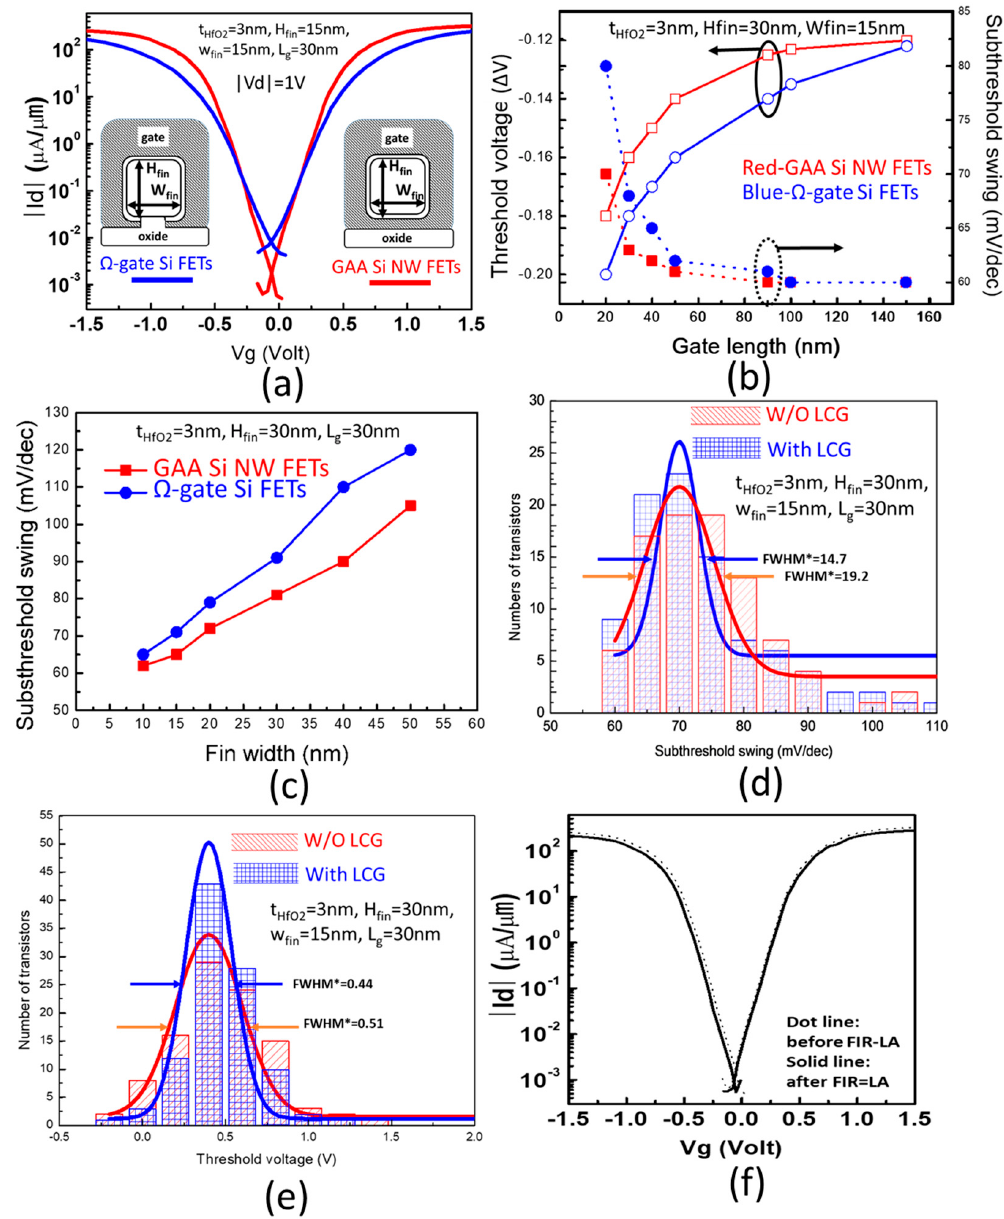
Figure 7. ( a ) A comparison of transfer characteristics between Ω -gate Si FETs and GAA Si NW FETs; ( b ) the dependencies of threshold voltage and S.S. on the transistor gate length (L g ); ( c ) the dependency of S.S. on the fin width (W Fin ); the distributions of ( d ) S.S. and ( e ) V th of the GAA Si NW FETs with and without the LCG technique; ( f ) the transfer characteristics of a GAA Si NW FET before and after the FIR-LA.